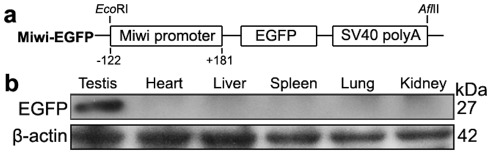

Miwi-EGFP transgenic construct and expression in transgenic mice.a), Schematic depiction of transgenic Miwi-EGFP construct, which contains a region of the Miwi promoter from −122∼+181 cloned into a pEGFP-1 vector. The EcoRI-AflII fragment was used for microinjection. b), Western blot analysis of the EGFP protein in the adult testis, heart, liver, spleen, lung and kidney in Miwi-EGFP transgenic mouse. The EGFP expression was only detected in the testis. β-actin served as an internal control.